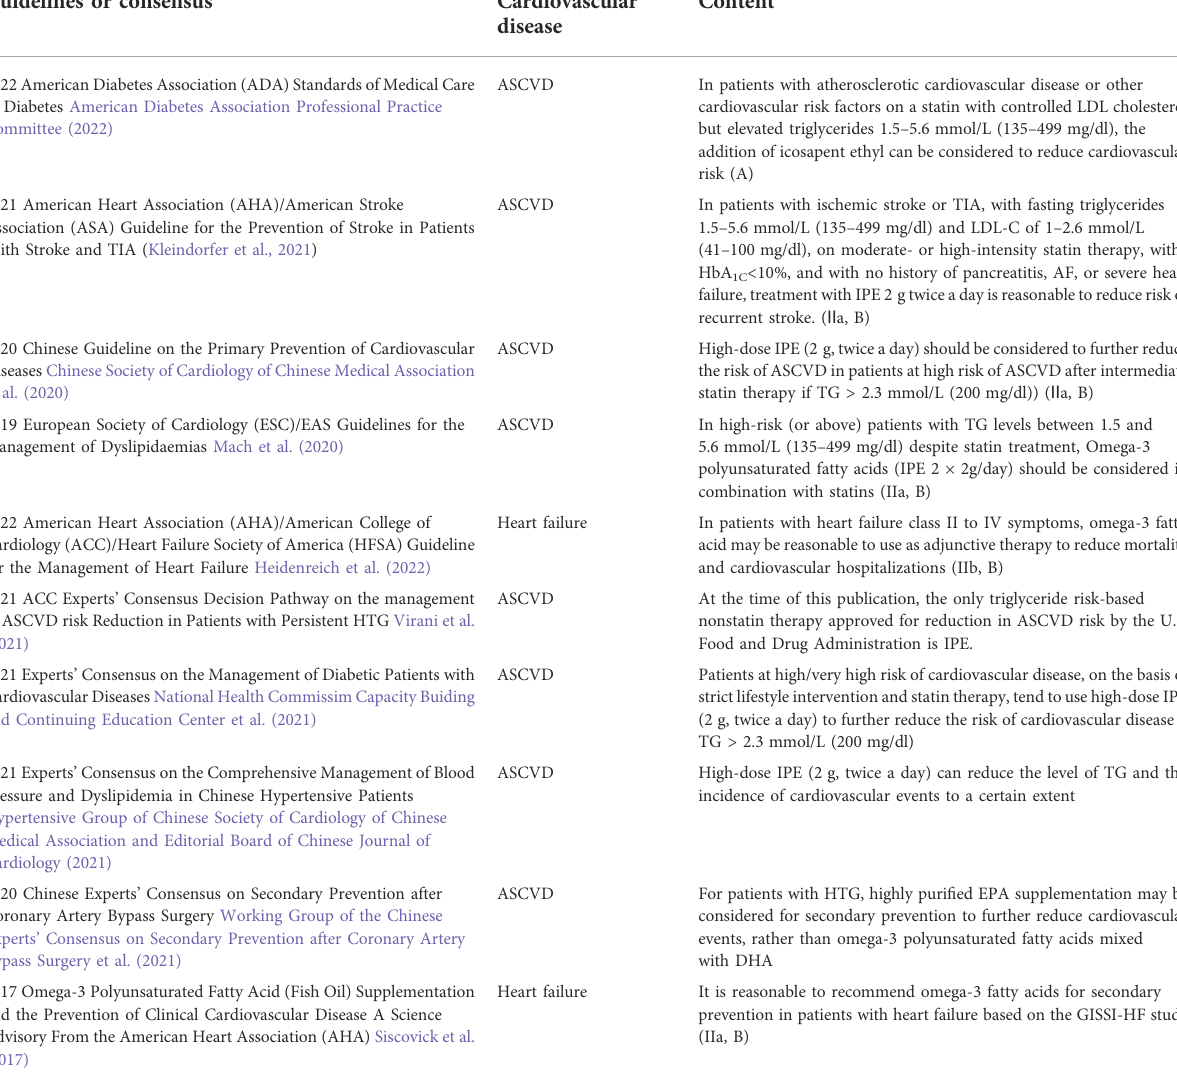
TABLE 3 Recommendation of Omega-3 fatty acids for the treatment of cardiovascular diseases in major guidelines or consensus in China and